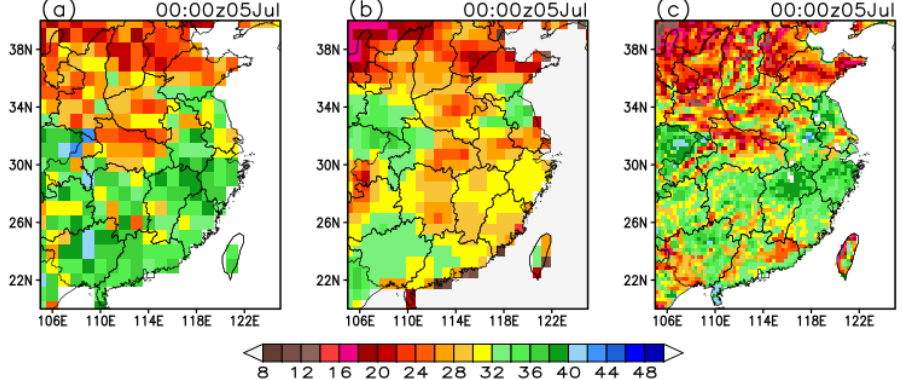
Figure 5. The top-layer soil moisture of ( a ) the FNL (units: %); ( b ) the ERA (units: %) and ( c ) the Merged (units: %) simulations.